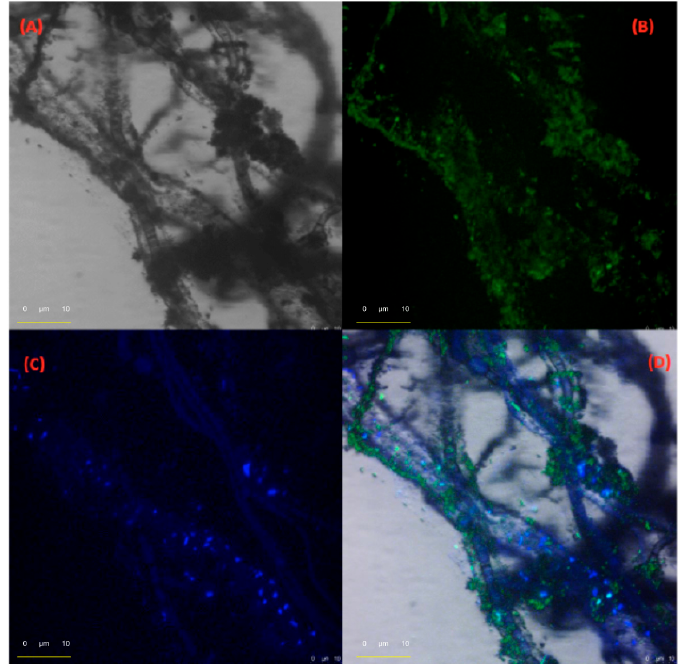
Figure 4. Optical and confocal microphotographs showing microfibres assembled between FeNP- NDI-DA (green) and DB[ah]A (blue) in aqueous media.: ( A ) Transmitted light micrograph. ( B ) Fluorescent micrograph λ exc = 448 nm, λ em = 517 nm (FeNP-BDI-DA). ( C ) Fluorescent micrograph λ exc = 405 nm, λ em = 454 nm (DB[ah]A). ( D ) Micrograph Composition of A, B, C.